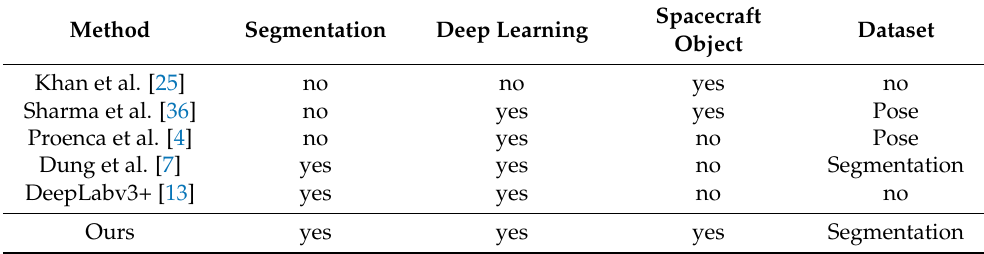
Table 1. The comparison table of related